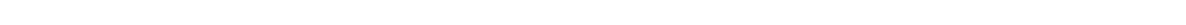
Fig. 7 PPAR γ antagonism restores metabolic homeostasis in ROR α LKO mice. a – e ROR α f/f and ROR α LKO mice were fed HFD with or without GW9662 for 5 weeks ( n = 4 – 5 per group). a Body weight curves. Statistical analysis was performed using Student ’ s unpaired t -test. * P < 0.05, ROR α f/f vs ROR α LKO , vehicle. b , c Liver b and epidydimal white adipose tissue (eWAT) c weight of ROR α f/f and ROR α LKO mice were fed HFD with or without GW9662 for 5 weeks. Statistical analysis was performed using two-way ANOVA. * P < 0.05, ** P < 0.01. d , e Representative histological section images from eWAT d and liver e of ROR α f/f and ROR α LKO mice fed HFD with or without GW9662 for 5 weeks. Scale bar, 100 μ m. f , g Expression levels of PPAR γ target genes f or gluconeogenesis/lipogenesis/lipid sequestration genes g in liver from ROR α f/f and ROR α LKO mice fed HFD with or without GW9662 for 5 weeks as determined by quantitative PCR with reverese transcription. Expression was normalized to 36B4 expression. Statistical analysis was performed using Student ’ s unpaired t-test. * P < 0.05, ** P < 0.01, *** P < 0.001, # P < 0.05 compared to each vehicle group. Data expressed as mean ± s.e.m. h Proposed model for the role of ROR α in hepatocyte. ROR α regulates PPAR γ signaling via HDAC3 recruitment to the PPAR γ target promoters for